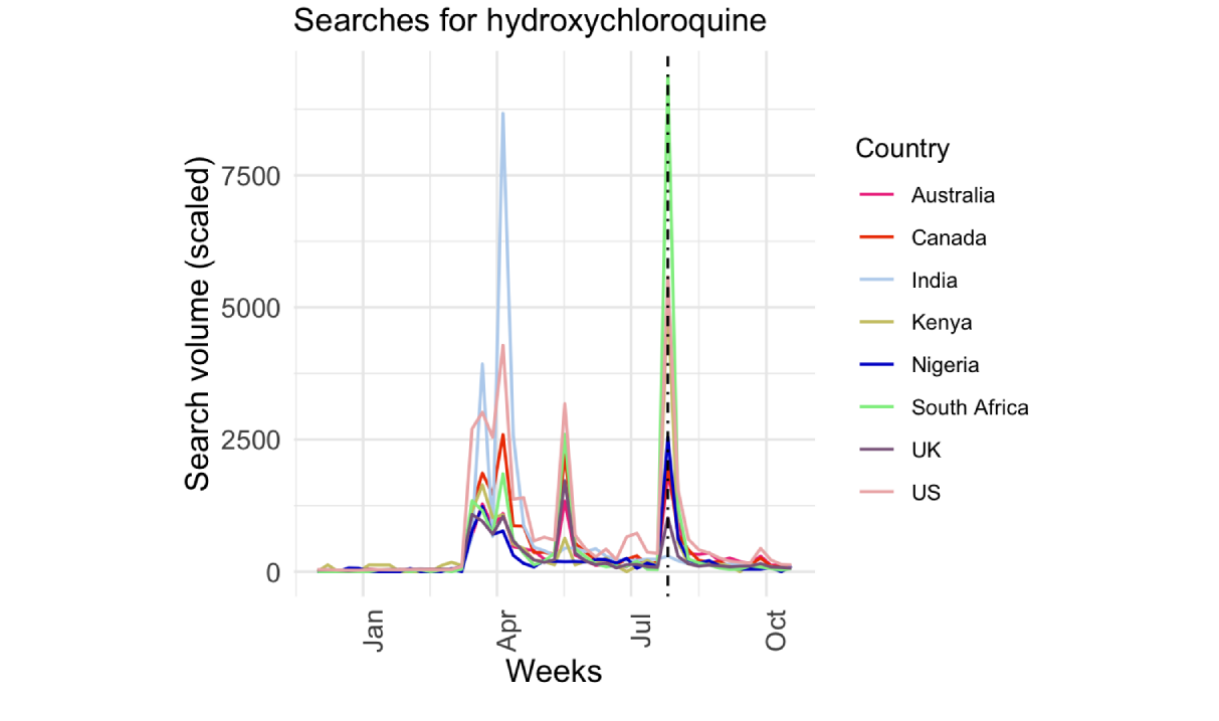
Figure 3. Trends in searches for hydroxychloroquine across 8 countries from December 2019 to October 2020. The black vertical line indicates the time the World Health Organization included the topic on the Mythbusters